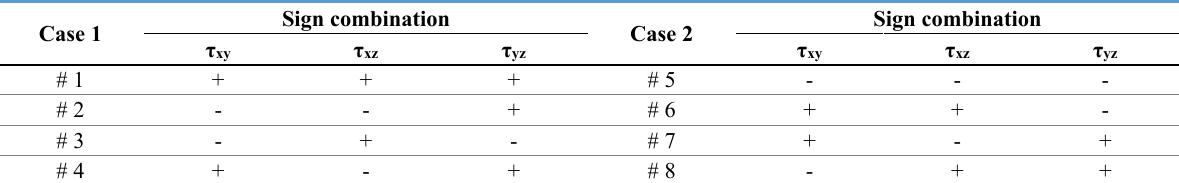
Table 1. Shear stress sign